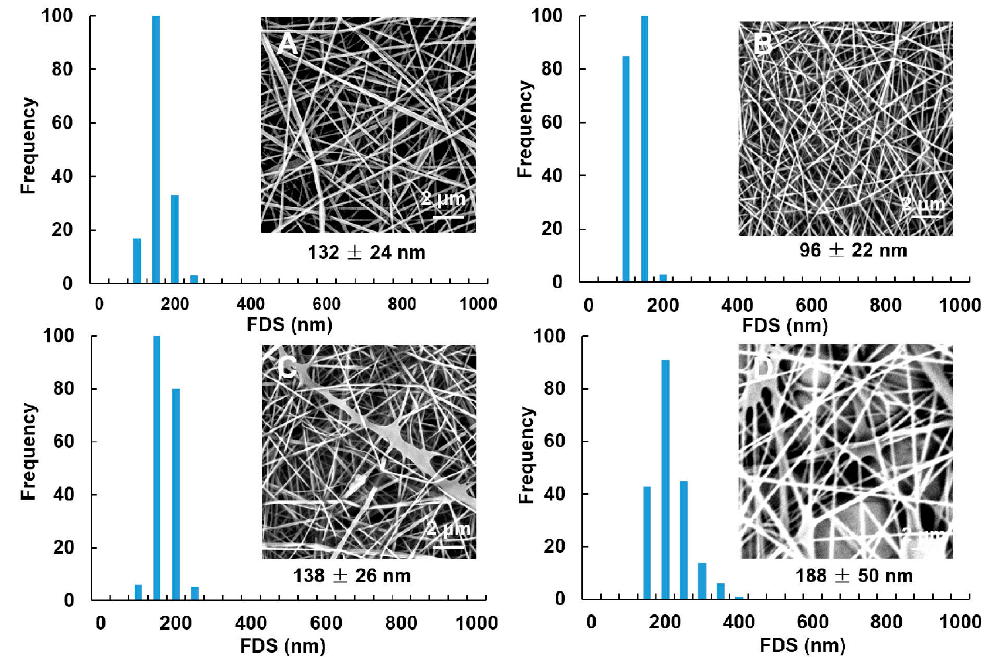
Figure 4. SEM images and fiber diameter size (FDS) of electrospun fibers obtained from GG solutions at 2 wt % concentration loaded with: 5 wt % TA ( A ); 10 wt % TA ( B ); 15 wt % TA ( C ); and 20 wt % TA ( D ). Magnification is 10,000 × .